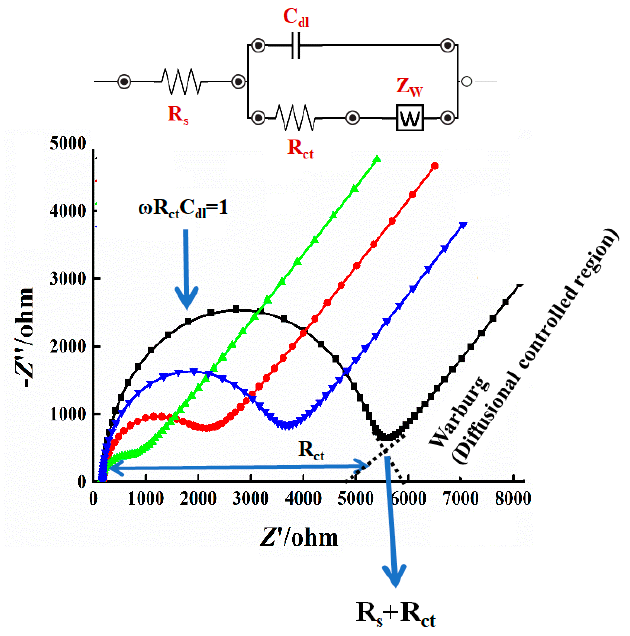
Figure 4. Experimental and simulated impedance spectra showing a simplified Randles equivalent circuit for an electrochemical system (original data obtained by our team). Impedance measurement is formed by Nyquist plot, which is constructed into two-dimensional X- and Y-axes for the real and the imaginary impedances, respectively. The X -axis is a real part of impedance (Z real ), which represents R s , R ct, and W values. The Y -axis is an imaginary part of impedance (Z imag ). EIS experiments were conducted in a homemade conventional electrochemical cell consisting of reference, counter, and working electrodes. Ferricyanide (1 mM) was used as the standard redox probe. EIS parameters were adjusted at AC potential of 5 mV, and the applied frequency sweeps extended from 10,000 to 0.1 Hz.